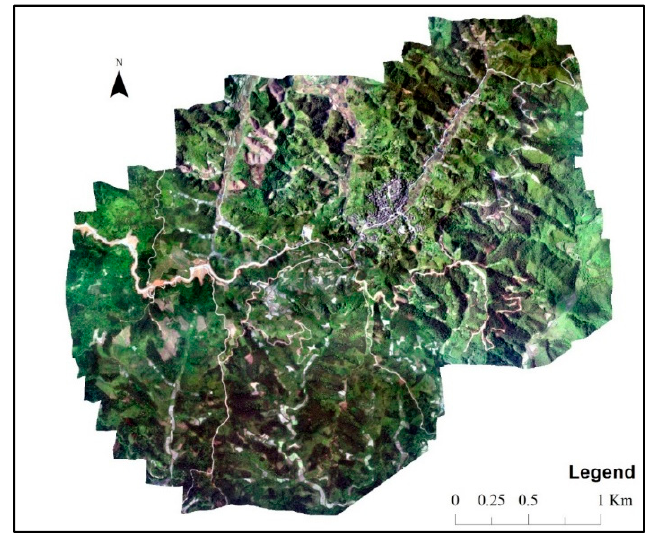
Figure 3. Orthophoto mosaic (11 cm pixel size) of Gaoyou in 2019. Table 2. Land use